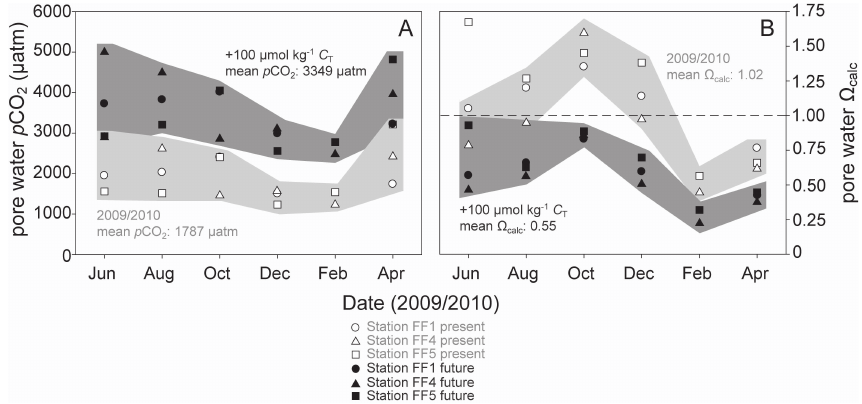
Fig. 9. Present (white symbols) and future (black symbols) sediment pore water (0–1cm) p CO 2 (A) and (cid:127) calc (B) at stations FF1, FF4, and FF5. Future sediment pore water p CO 2 and (cid:127) calc were replotted from Table 4 and calculated after addition of 100µmolkg − 1 C T to C T